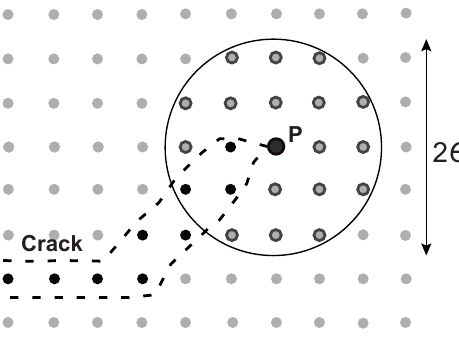
Figure 1. Scheme of a set of fractured material points as a fractured layer (black dots) and the (cid:101) -neighborhood of the points neighbors of the material point at the crack tip (gray